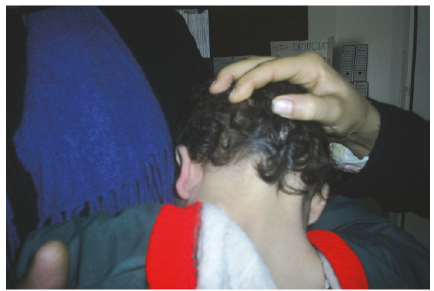
Figure 2: Low hairline and low dysmorphic auricles.